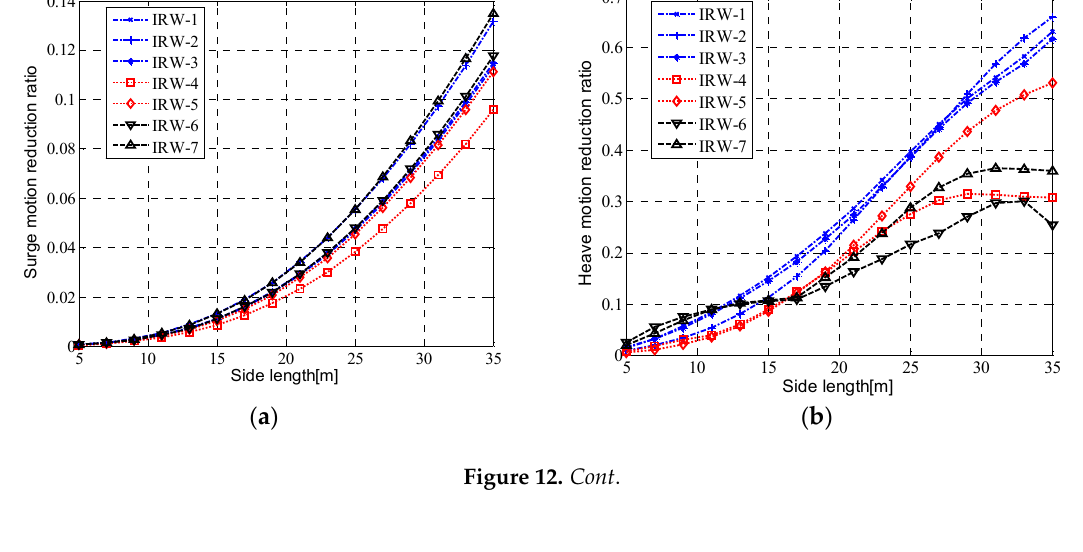
Table 4. Characteristic wave parameters of seven irregular wave sea states.